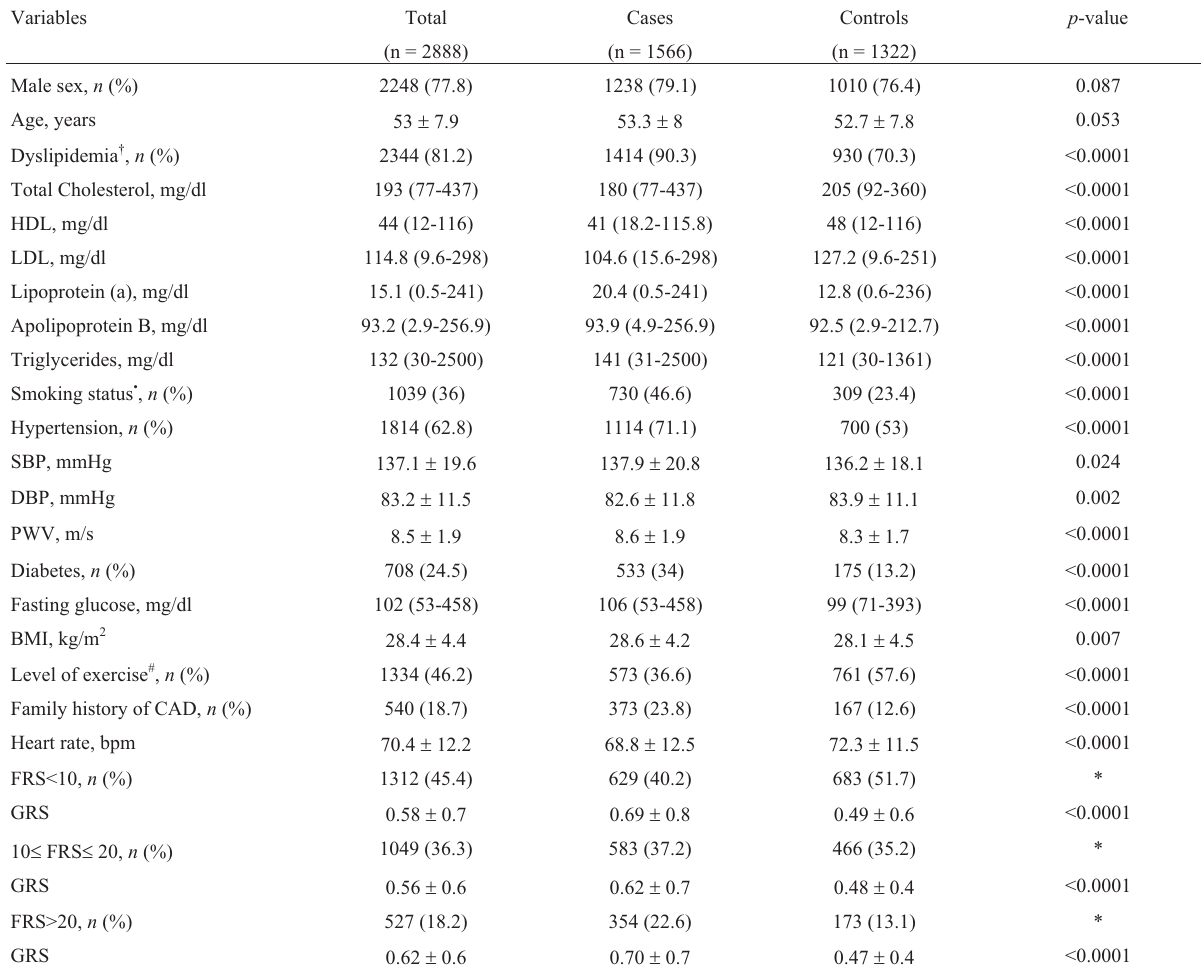
Table 1 - Baseline characteristics for both CAD patients and